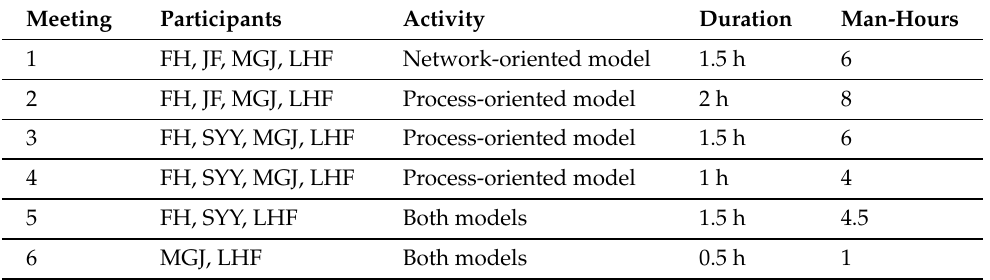
Table 1. Overview of the threat modeling process.